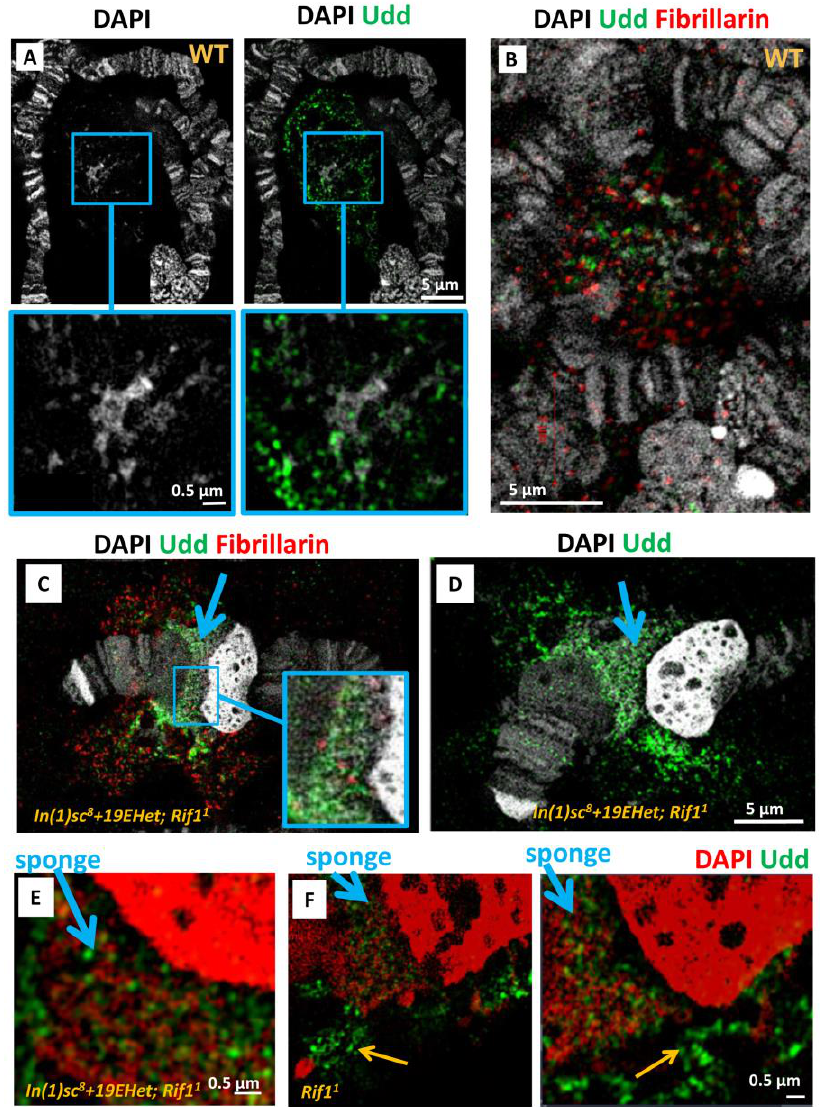
Figure 7. Udd is present both in the spongy structure and in the extrachromosomal cloud of the NOR. ( A ) Wild-type polytene chromosomes stained with DAPI and Udd antibodies. ( B ) Udd, fibrillarin and DAPI localization in wild-type polytene chromosomes. ( C ) In(1)sc 8 + 19EHet; Rif1 1 chromosomes immunostained for Udd and fibrillarin. ( D ) Same as ( B ) without fibrillarin. ( E ) Close-up view from ( D ) showing Udd dots in the spongy area (blue arrows) and in the cloud (yellow arrows). ( F ) Rif1 1 chromosomes immunostained for Udd (all designations correspond to ( E )). All images represent slices from 3D-SIM image stacks.